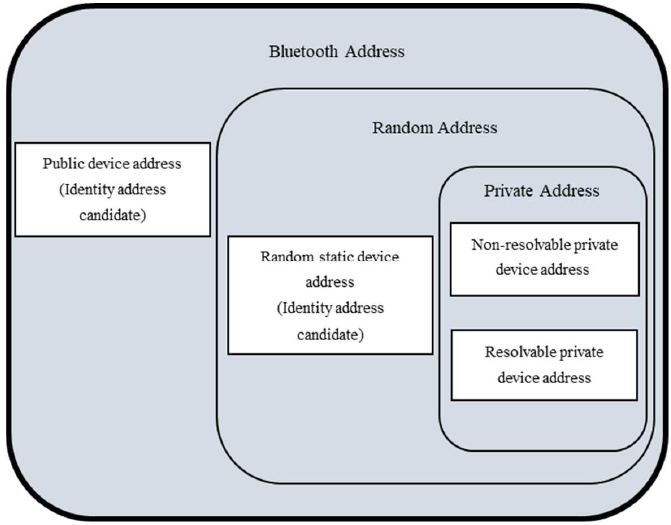
Figure 2. Family of Bluetooth address.